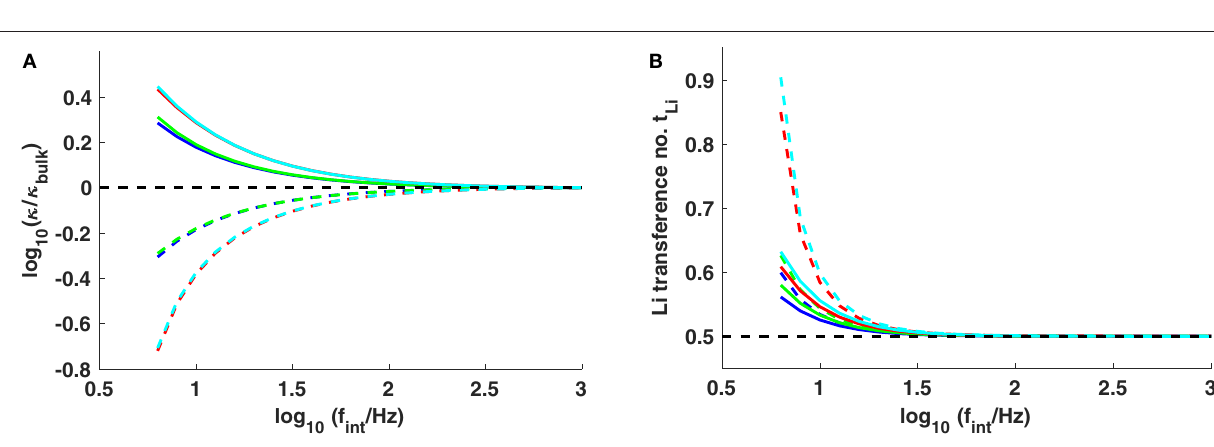
FIGURE 5 | (A) Conductivity and (B) lithium transference number at the surfaces of the positive (dashed lines) and negative (solid lines) electrodes, plotted vs. interfacial frequency f int . The systems studied are Li 0.5 C 4 mim 0.5 BF 4 (blue), Li 0.5 C 8 mim 0.5 BF 4 (green), Li 0.5 C 4 mim 0.5 Tf 2 N (red), and Li 0.5 C 8 mim 0.5 Tf 2 N (cyan). The black dashed lines show κ = κ bulk in (A) and t Li = 0.5 in (B)